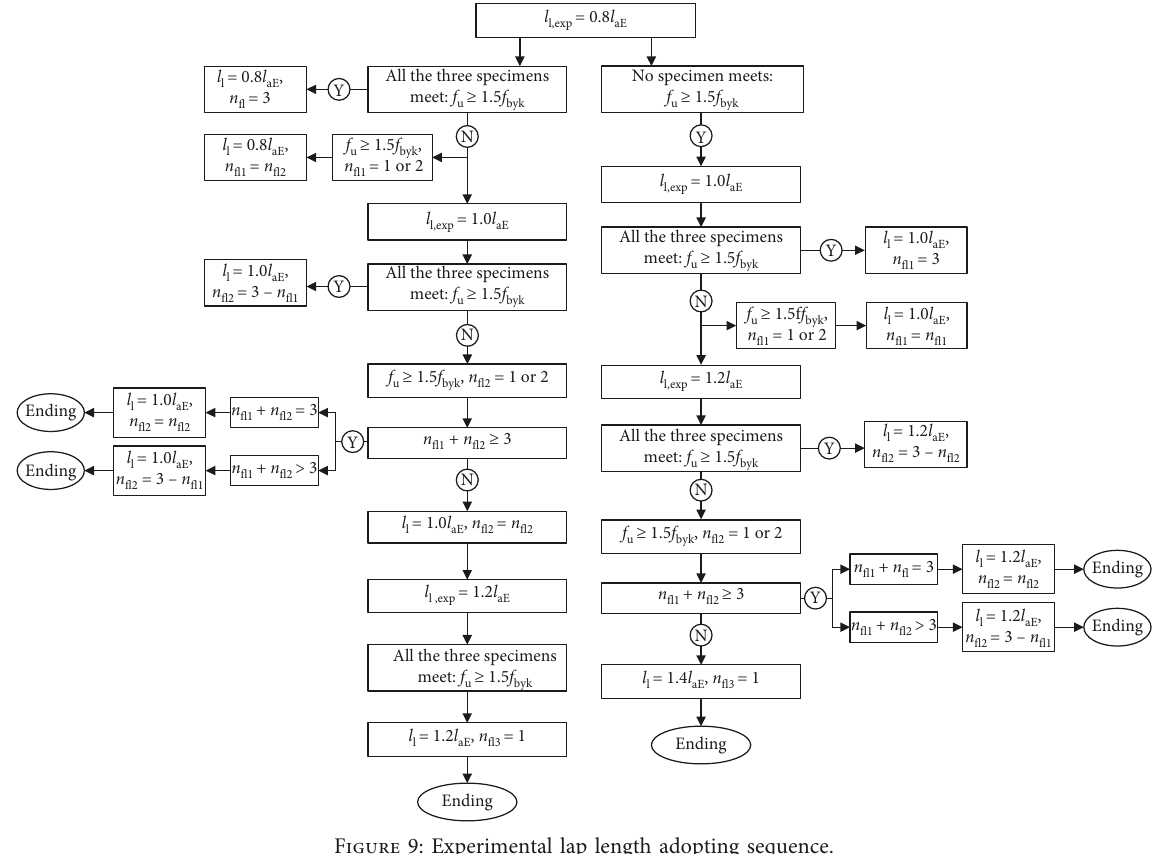
Figure 9: Experimental lap length adopting sequence.